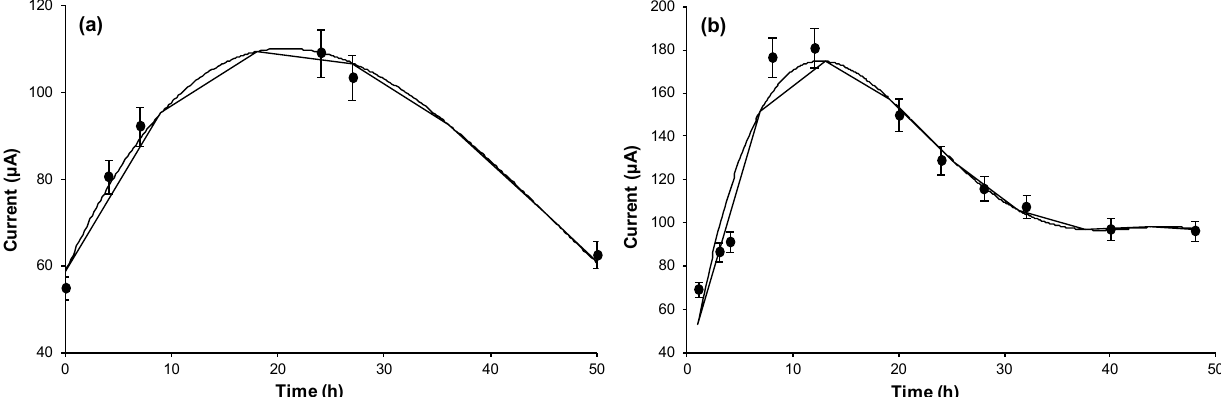
Figure 2. Current intensity recorded as the amount of yeast (g) in solution increases, for a fixed glucose concentration of 0.056 mol L −1 .